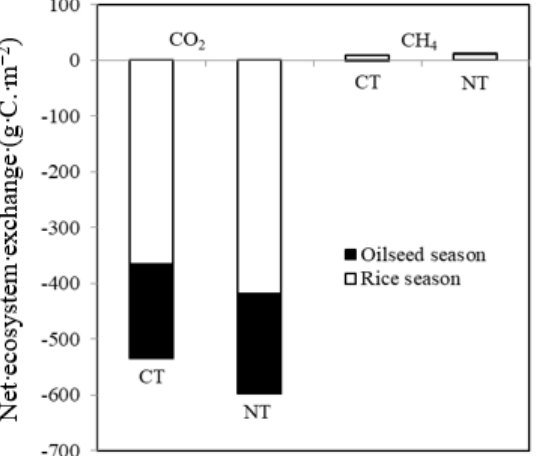
Figure 3. Seasonal CH 4 and CO 2 net ecosystem exchange (NEE) under CT and NT management in a rice-oilseed rape cropping system.